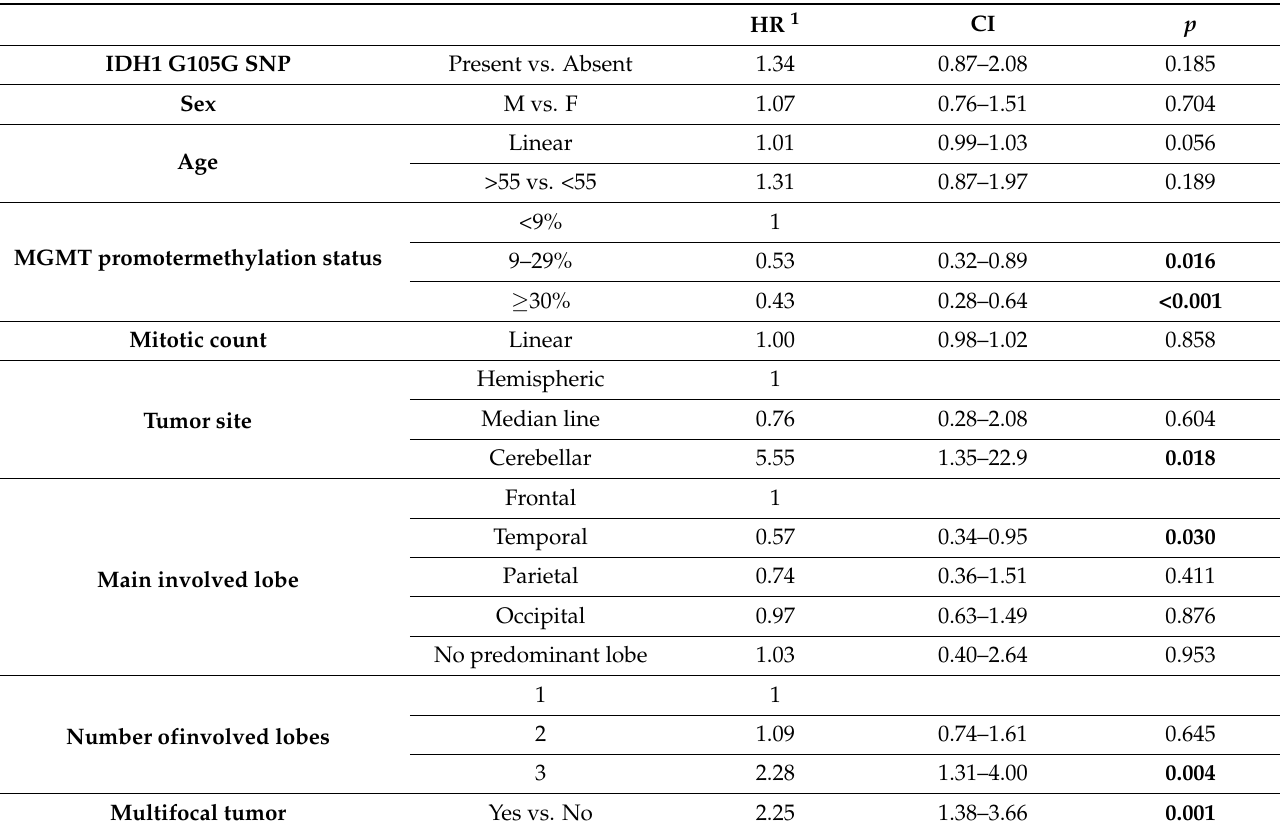
Figure 2. DSS according to IDH1 G105G status. No significant difference was detected ( p = 0.1833). Table 4. DSS analysis of clinical/pathological/molecular features by Cox regression.